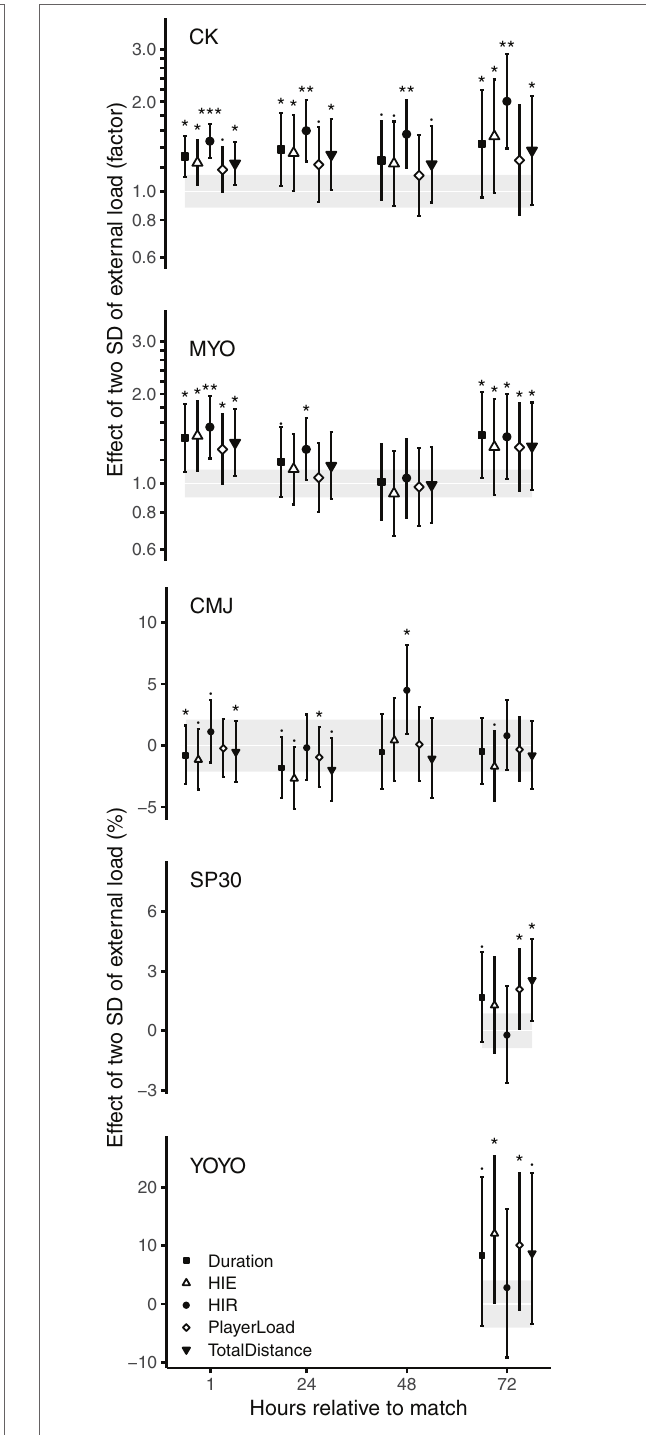
FIGURE 3 | The factor or percent effect of two SDs of match load on recovery markers at the specific time-points, adjusted for baseline and YOYOmax. Two SDs of match load are interpreted as the difference between matches with typical high and low load. Uncertainty in the estimates is indicated by 90% confidence intervals and shaded area represents trivial changes. Probabilistic statements about the true effect are labeled as follows: · = possibly, * = likely, ** = very likely, and *** = most likely.